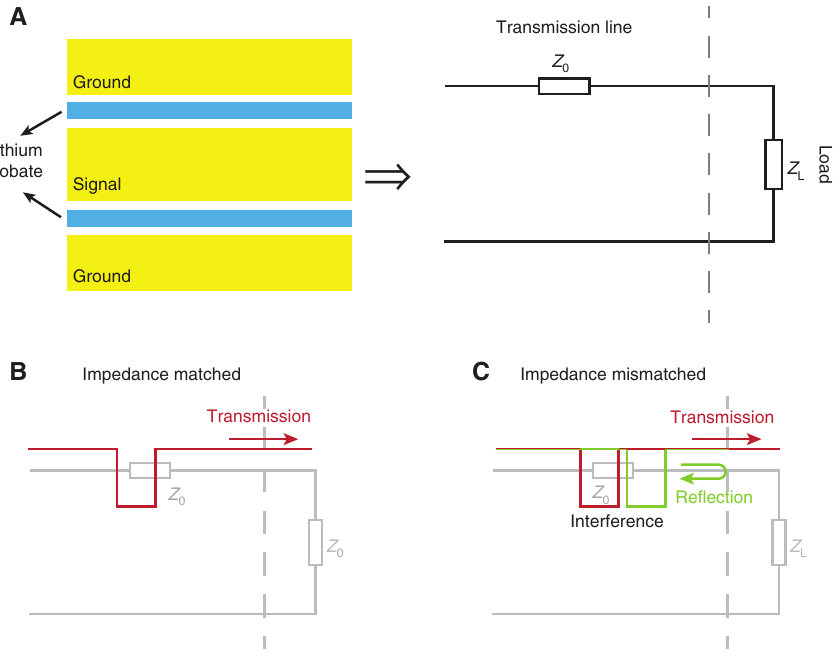
Figure 18: Schematic of impedance matching of traveling-wave modulators. (A) Transmission-line model of the coplanar waveguide for microwave signal. (B) If impedance of the transmission line Z impedance Z , the reflection will be minimized. (C) If the impedance of the transmission line mismatches the load impedance, part of the L microwave signal will be reflected back to the transmission line. Such a reflected wave will interfere with the modulation microwave signal, leading to a standing wave and bringing phase error to the modulated optical